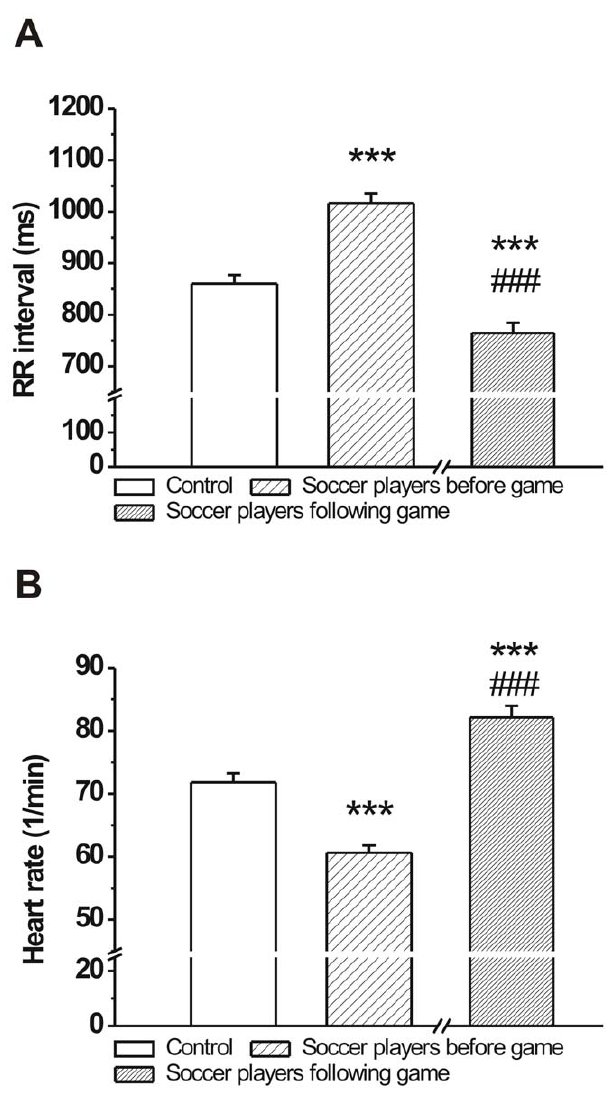
Figure 1. The RR interval and heart rate of age-matched controls and professional soccer players before and following a competitive game. A : The RR interval was significantly longer ( A ) and heart rate was significantly lower ( B ) in soccer players before the game compared to controls (n=76 persons/group; ***p , 0.001 vs. age- matched control; Means 6 S.E.M.; ### p , 0.001 vs. before game values).